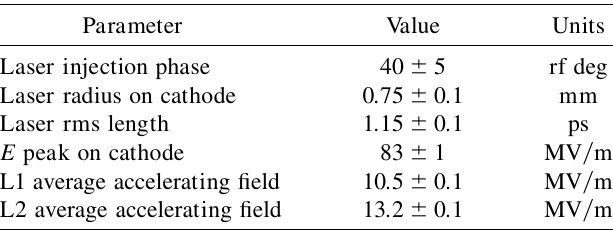
TABLE I. Nominal settings for the rf gun, accelerating sections, and the photocathode drive laser. The values have been directly measured or inferred from the beam